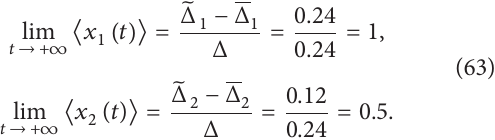
Figure 2: Solutions of system (3) for 𝑟 10 = 0.85 , 𝑟 20 = 0.05 , 𝑟 11 = = 1 , 𝑎 = 0.4 , 𝑎 = 0.4 , 𝑎 = 0.3 , 𝑎 = 0.3 , 𝜏 𝑟 21 11 12 21 22 = 0.4 , 𝛼 2 = 0.1 , 𝑘 = 𝑔 = 𝑚 = 0.1 , 𝑖 = 1, 2 , ℎ = 0.5 , 𝑏 = 0.6 , 𝛼 2 𝑖 𝑖 𝑖 1 2 (0) = 0.9 , 𝑥 (0) = 0.5 , 𝐶 (0) = 𝐶 (0) = 0.1 , and step size 𝛾 = 0.8 , 𝑥 1 2 0 𝑒 Δ𝑡 = 0.001